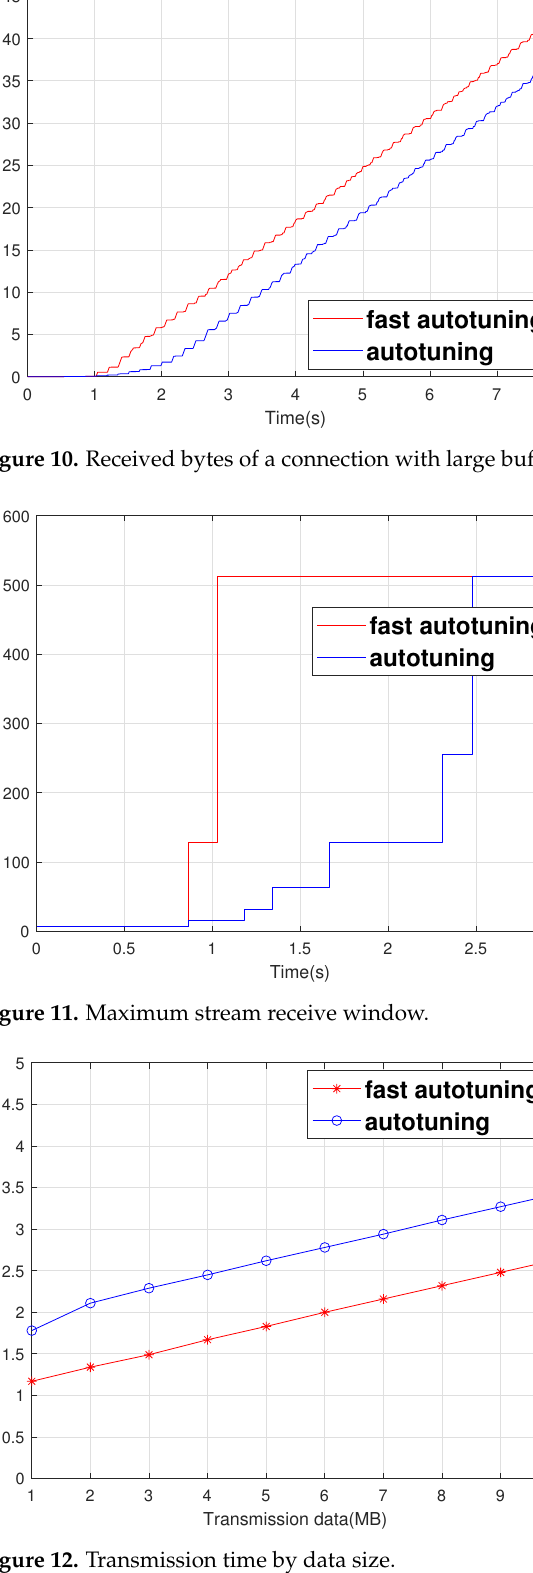
Figure 12. Transmission time by data